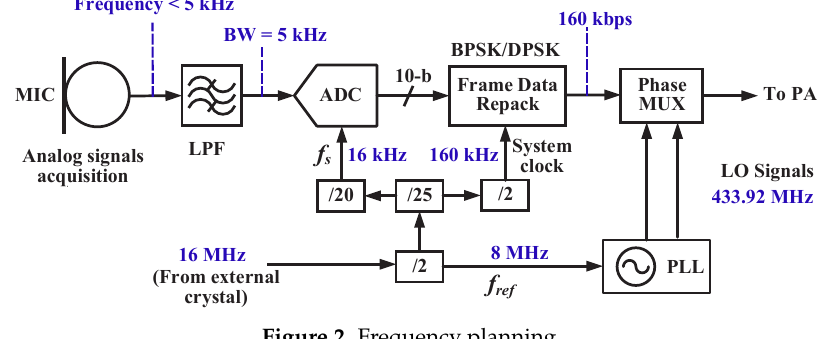
Figure 2. Frequency